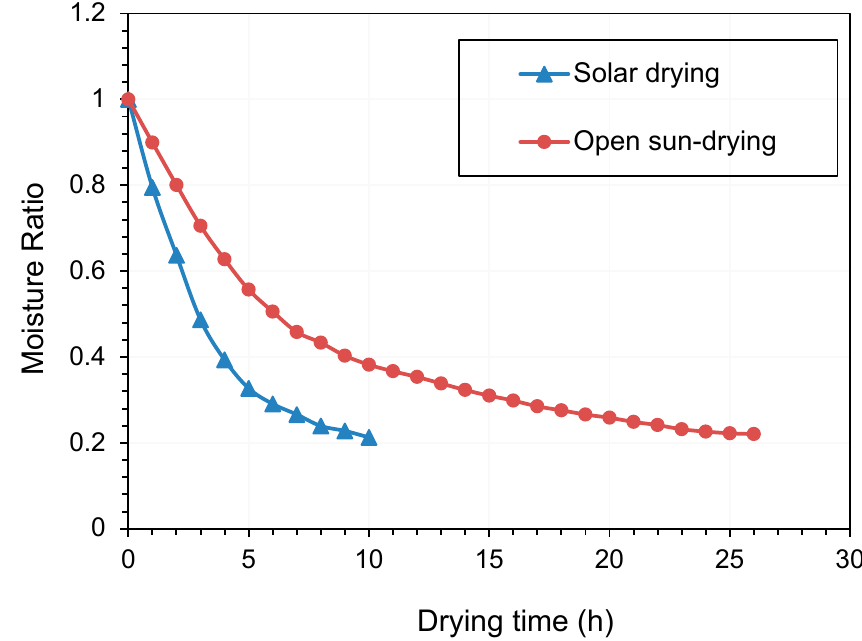
Figure 6. Drying kinetics of Qula by solar drying and open sun-drying. Table 5. Statistical results obtained from drying models in solar drying and open sun-drying.